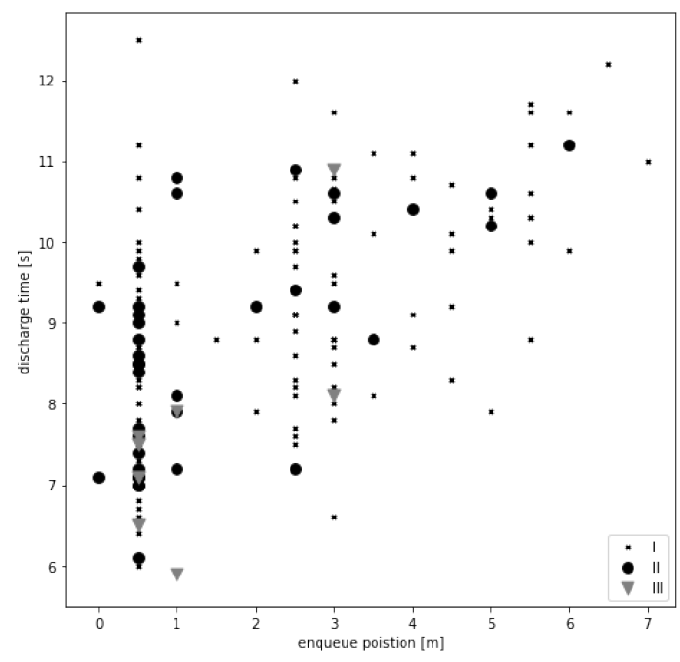
Figure 12. Enqueueing position vs. discharge time in respective